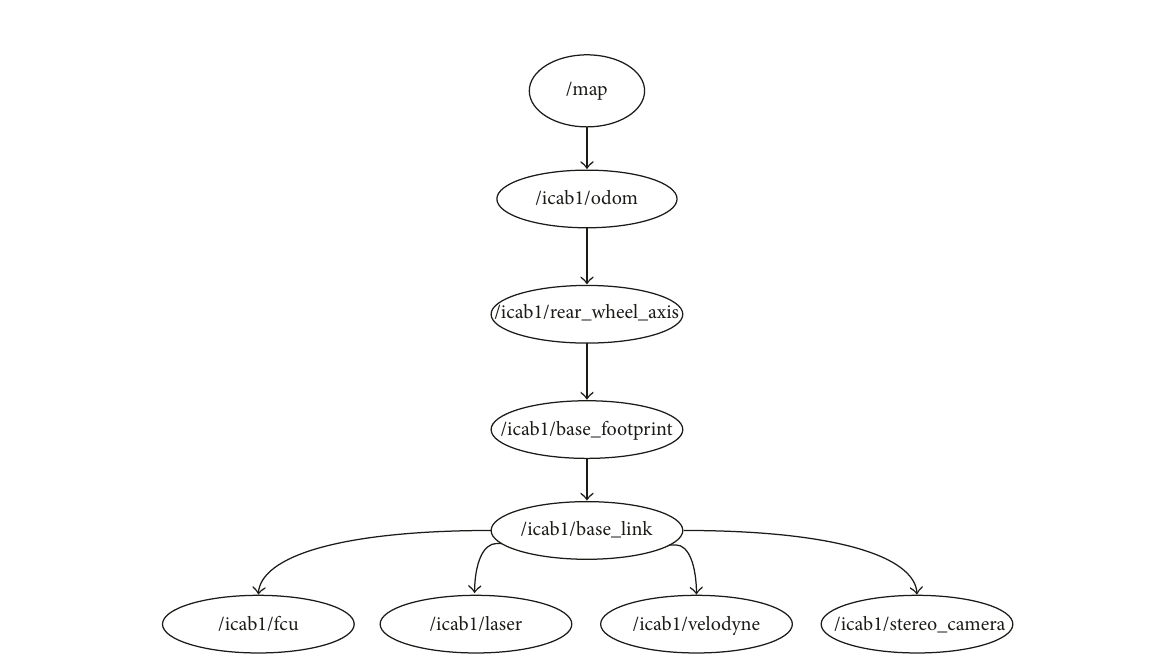
Figure 6: Software nodes sharing messages by topics in the partial software architecture.